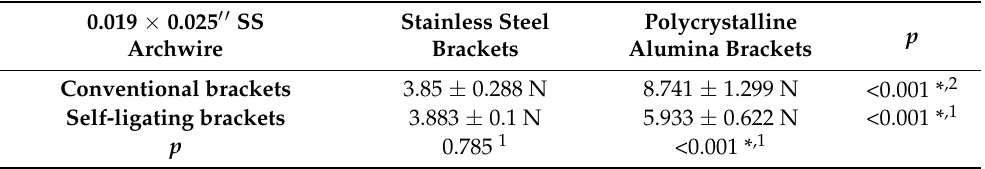
Table 3. Comparison of static frictional forces (mean values) measured for brackets with 0.019 × 0.025 (cid:48)(cid:48) SS